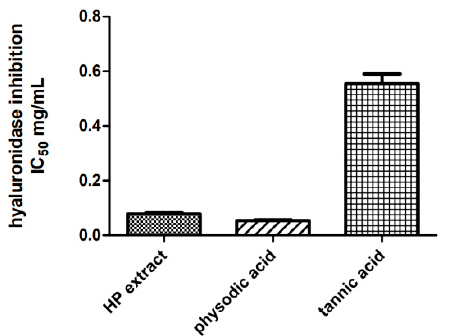
Figure 3. Inhibition of hyaluronidase by Hypogymnia physodic extract (HP extract), physodic acid and the references substance tannic acid. Results are presented as IC 50 values (mg/mL) ± SEM, calculated from five measurments ( n = 5) obtained from three independent experiments.